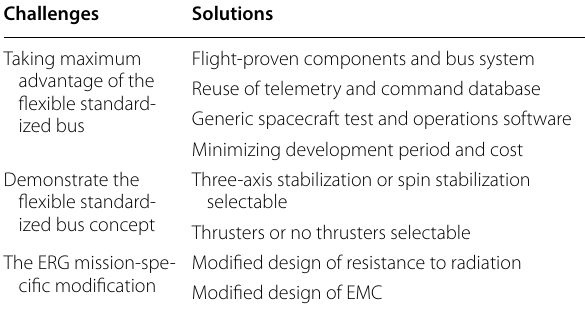
Table 7 Summary of the challenges